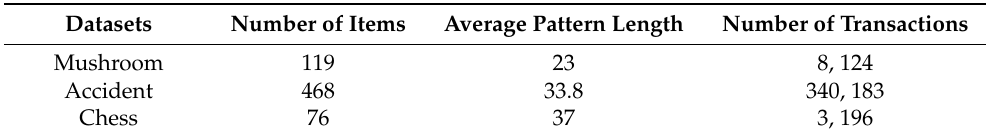
Table 7. Benchmark datasets